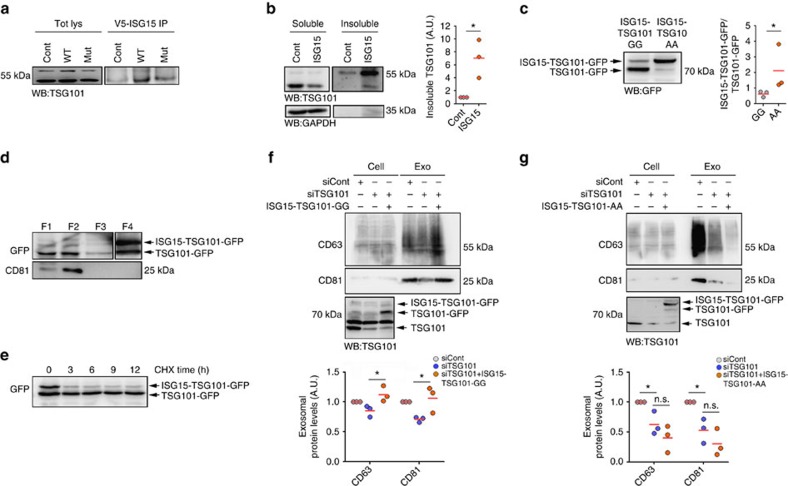
ISG15 impairs exosome secretion by modifying TSG101.(a) Western blot analysis of TSG101 immunoprecipitation in HEK293 cells non-transfected or HEK293 cells co-transfected with plasmids encoding the ISGylation machinery and functional (ISG15WT) or mutated ISG15 (ISG15MUT). Total lysates and V5 immunoprecipitates were blotted for TSG101. (b) Western blot analysis of 0.5% NP-40 soluble and insoluble fractions from non-transfected HEK293 cells (Cont) or cells transfected with ISG15 and ISGylation machinery (ISG15). Soluble and insoluble fractions were blotted for TSG101 and GAPDH. Right graph: quantification of TSG101 protein levels in insoluble fractions in three independent experiments. (c) Western blot analysis of TSG101-GFP ISGylation in HEK293 cells transfected with ISG15-TSG101-GFP-GG or with the non-de-ISGylable mutant ISG15-TSG101-GFP-AA. Cell lysates were blotted for GFP. Right graph: quantification of ISG15-TSG101-GFP/TSG101-GFP ratio in three independent experiments. (d) Western blot analysis of ISG15-TSG101-GFP and TSG101-GFP subcellular distribution in HEK293 cells transfected with ISG15-TSG101-GFP-GG. Fractions corresponding to cytosol (F1), membranes (F2), nucleus (F3) and insoluble aggregates (F4) were extracted and blotted for GFP and CD81. A lower exposition of the same blot is shown for F4. (e) Western blot analysis of ISG15-TSG101-GFP and TSG101-GFP degradation kinetics in HEK293 cells transfected with ISG15-TSG101-GFP-GG and treated with cycloheximide during the indicated times. Cell lysates are blotted for GFP. (f) Western blot analysis of HEK293 cells transfected with control small interfering RNAs (siRNAs) or siRNAs targeting TSG101. When indicated, cells were co-transfected with ISG15-TSG101-GFP-GG. Cells and EVs (EXO) were blotted for CD63 and CD81. Lower gel shows cell lysates blotted for TSG101 to check TSG101 silencing and exogenous overexpression. Lower graph: quantification of exosomal protein levels in three independent experiments. (g) Western blot analysis of HEK293 cells transfected with control siRNAs or siRNAs targeting TSG101. When indicated, cells were co-transfected with the non-de-ISGylable mutant ISG15-TSG101-GFP-AA. Cells and EVs (EXO) were blotted for CD63 and CD81. Lower gel shows cell lysates blotted for TSG101 to check TSG101 silencing and exogenous overexpression. Lower graph: quantification of exosomal protein levels in three independent experiments. Data b,c: t-test; NS: P-value>0.05 and *P-value<0.05. Data f,g: analysis of variance; NS: P-value>0.05 and *P-value<0.05.